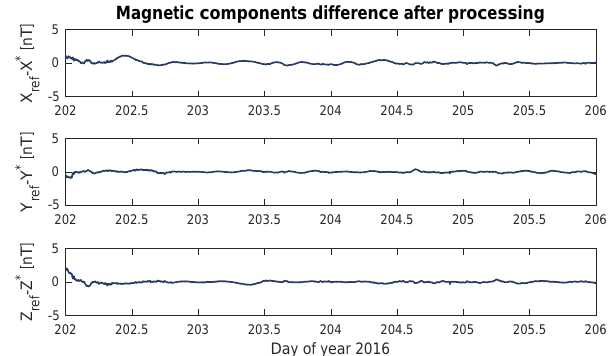
Figure 5. Variometer difference between a reference variometer and the case study variometer. The value are clearly within